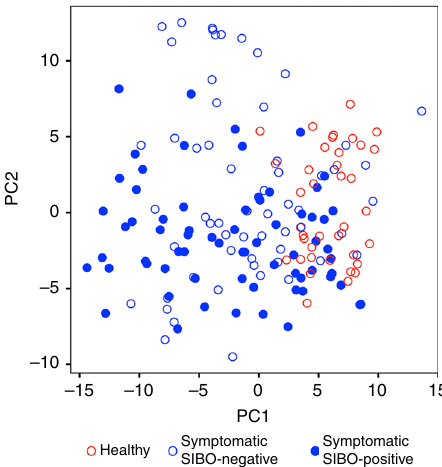
Fig. 4 Quantitative small bowel culture does not re fl ect small bowel microbial composition. Distribution of microbial communities from symptomatic patients (blue) with and without SIBO based on Aitchison distance from healthy microbial communities (red). SIBO does not correlate with microbial community composition as summarized by dysbiosis classi fi cation ( p = 0.33, Fisher ’ s exact test). Open circles represent small bowel microbiomes from individuals who tested negative for SIBO; closed circles represent those tested positive for SIBO by aspirate culture